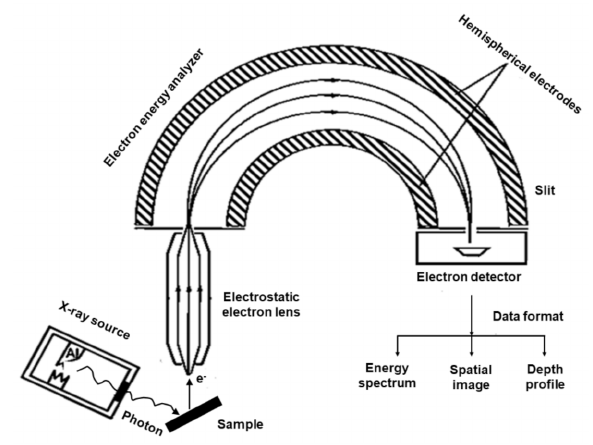
Figure 3. X-ray photoelectron spectroscopy experimental